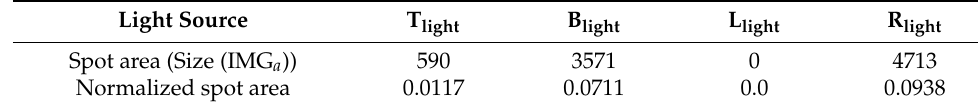
Table 2. Statistics of pre-imaging overexposures.